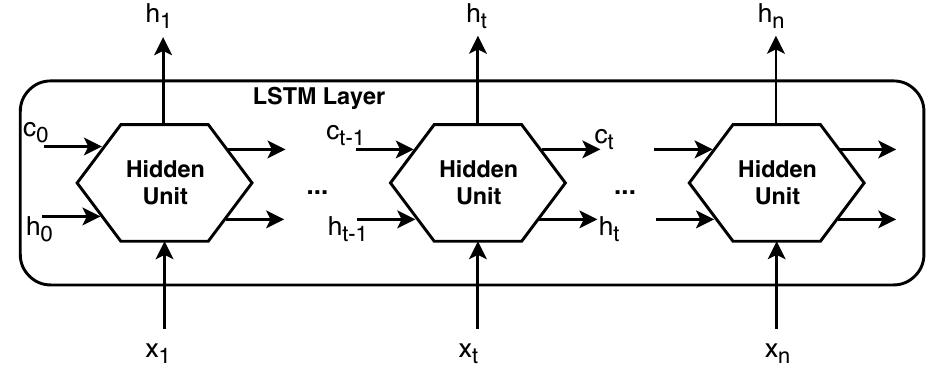
Figure 1. Long Short-Term Memory (LSTM) layer